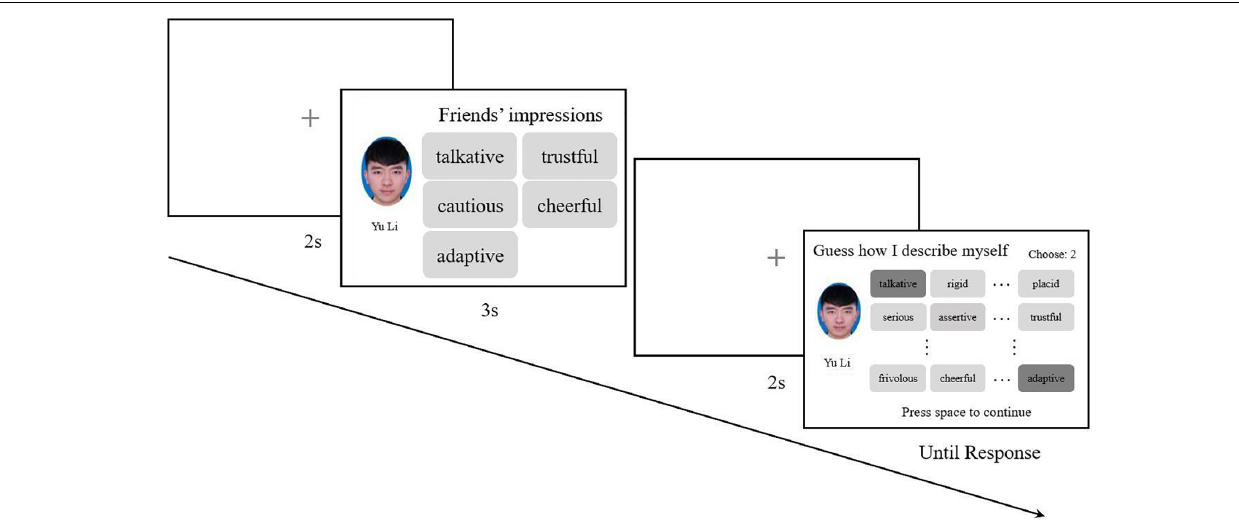
FIGURE 1 | For the first participants of each chain, five randomly chosen, non-repetitive words were combined with a random facial image for one trial, and each face would appear only once. In the probe phase, 44 words were listed in a 11 × 4 matrix for participants to choose from; the order of the words would be randomized for each trial. The combination of facial images and five impression words recognized by the previous participants would be randomly presented to subsequent